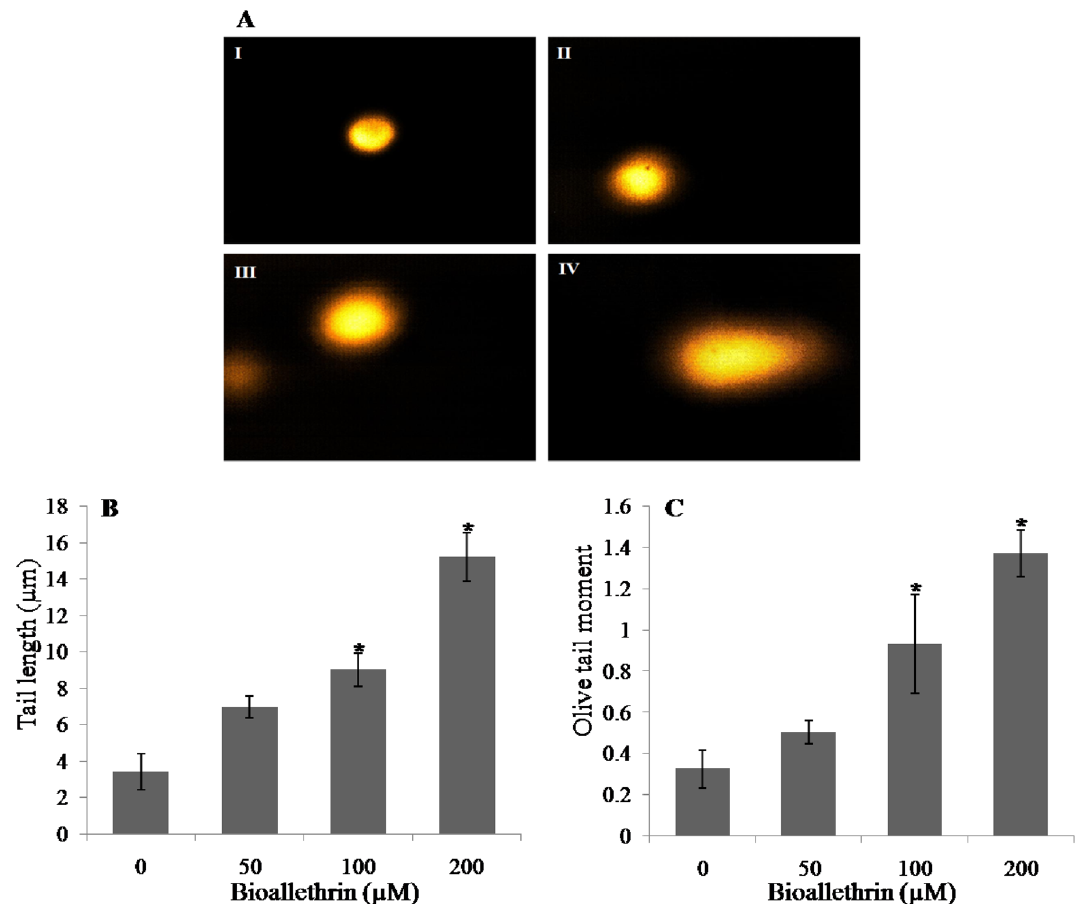
Figure 8. Effect of bioallethrin on nuclear DNA fragmentation examined by the comet assay. ( A ) The comet images are shown at 100 fold magnification (I) Control (untreated) lymphocytes. Cells treated with (II) 50 µM (III) 100 µM and (IV) 200 µM bioallethrin. ( B ) Comet tail length and ( C ) Olive tail moment. Lymphocytes were incubated with bioallethrin for 2 h at 37 °C. Data analysis was done by Komet 5.5, https:// andor. oxinst. com/ produ cts/ komet- softw are/ komet-7. Results are ± standard deviation of six different samples. *Significantly different from control at p < DNA damage. Single cell gel electrophoresis (comet assay) was performed to decipher the genotoxicity of bioallethrin in terms of nuclear damage and DNA scission. Nuclear DNA strand scission, upon gel electro- phoresis, generates a tail whose length is directly proportional to damage.Olive tail moment is the product of the tail length and the fraction of total DNA in the tail. In contrast to untreated cells, increasing concentrations of bioallethrin resulted in comets having longer tails showing concentration-dependent DNA damage (Fig. 8A). In addition, the comet tail length and olive tail moment were remarkably increased to more than four fold of control in 200 µM bioallethrin exposed lymphocytes (Fig. 8B,C). Nuclear morphology.